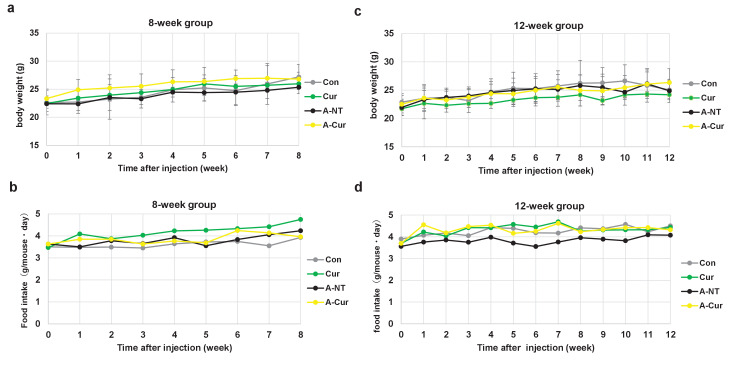
Weekly body weight and food intake measurements.(a) Body weight and (b) food intake in the 8-week group. Each column and bar represent the mean ± S.D. (N = 3–5). (c) Body weight and (d) food intake in the 12-week group. Data are represented in g/mouse・day (food intake).